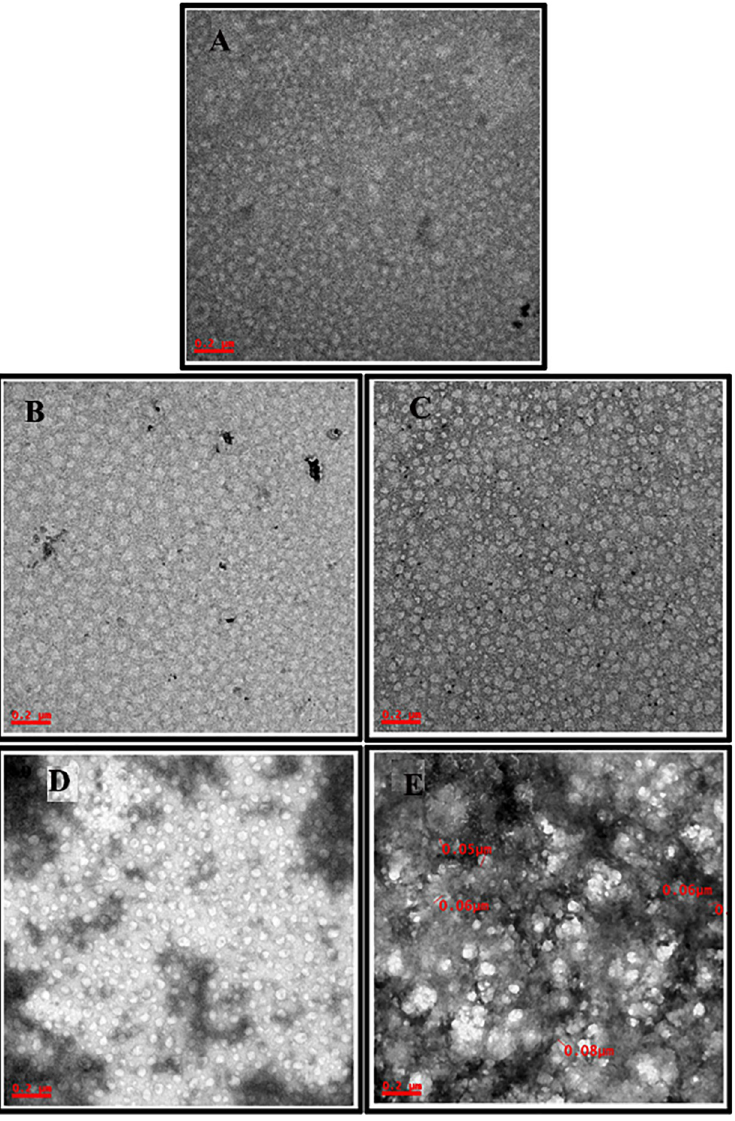
Fig 6. Transmission Electron Microscopic (TEM) studies to visualize alteration in HSA molecule topology in presence of withanolide and withanoside derivatives at 200 nM resolution. (A) Only HSA (B) HSA+withanolide A, (C) HSA+withanolide B, (D) HSA+withanolide IV and (E) HSA+withanolide V.